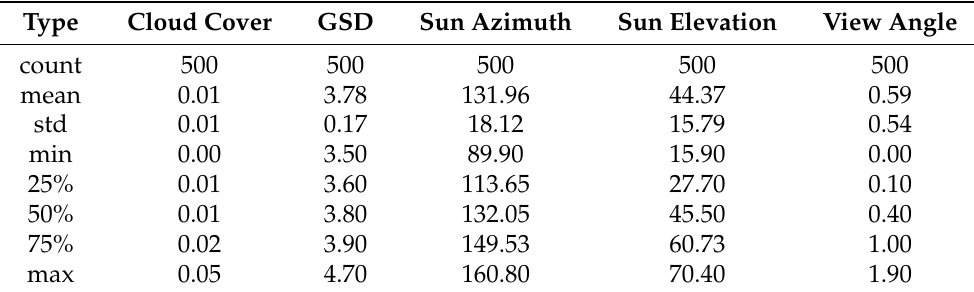
Table 5. Raw PlanetScope Imagery Characteristics.